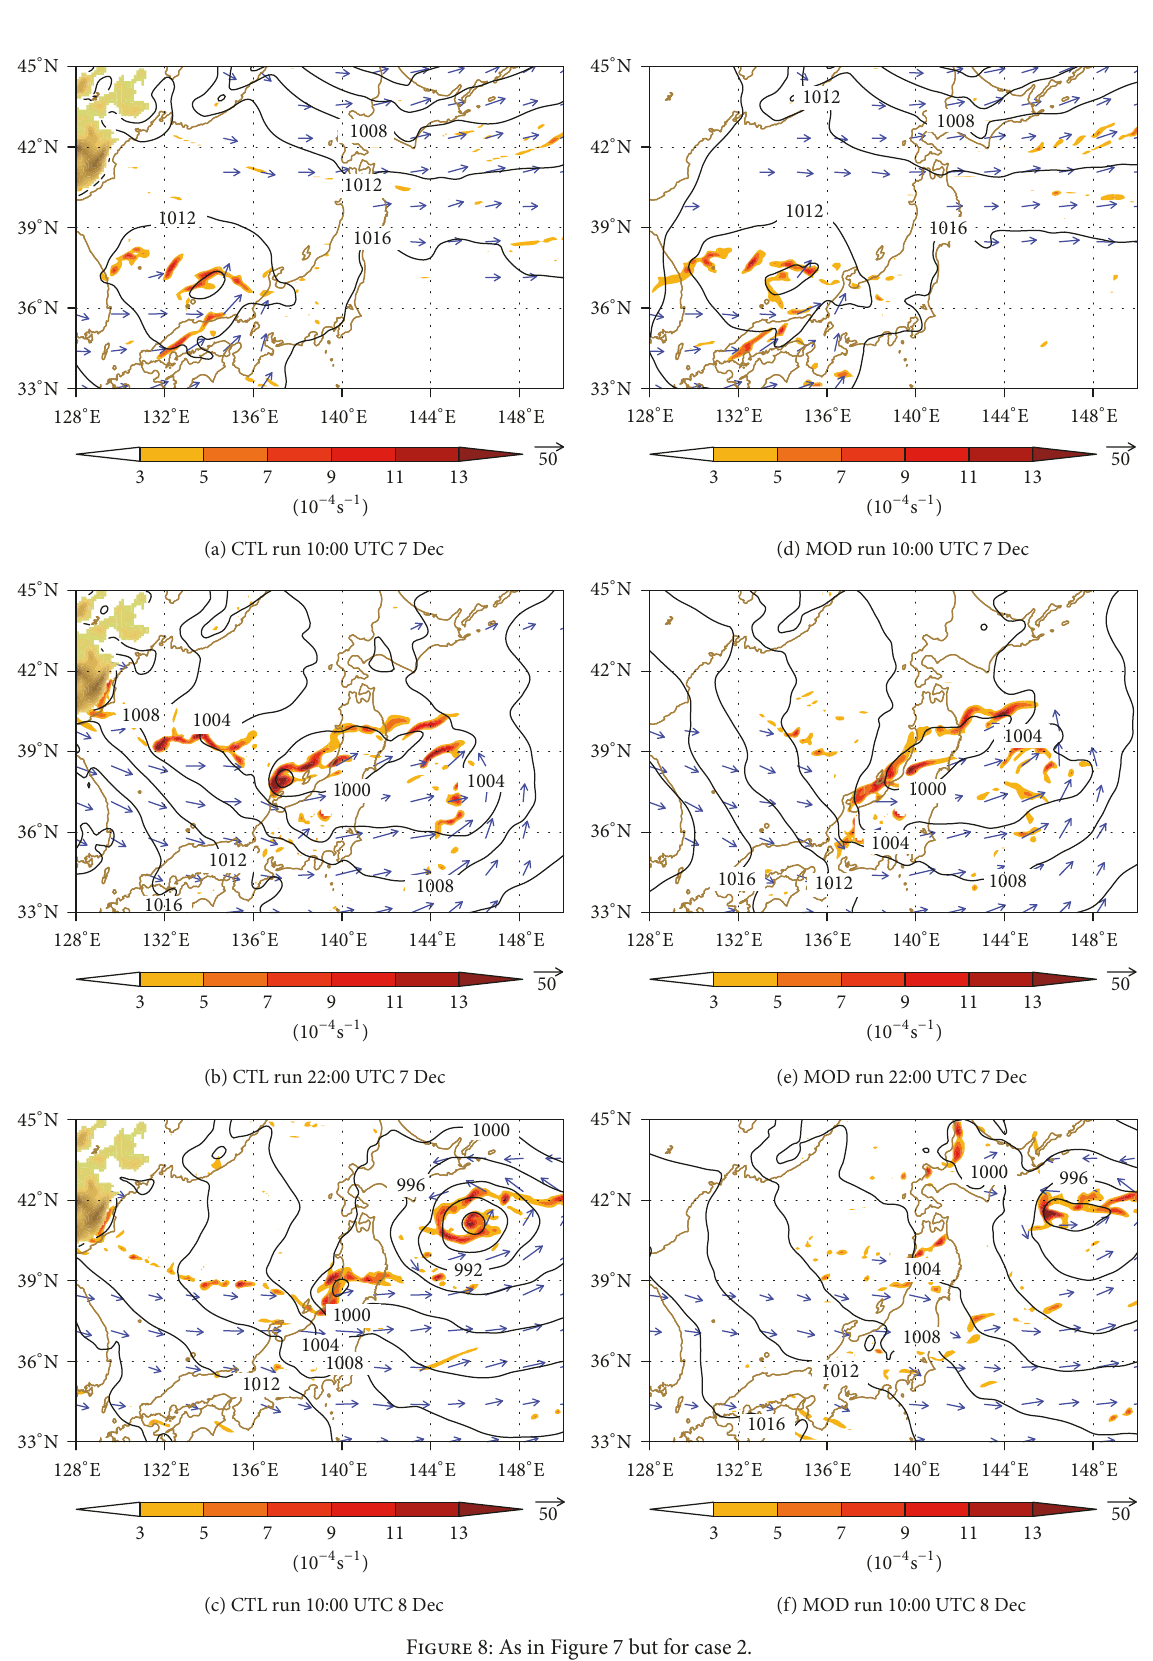
Figure 8: As in Figure 7 but for case